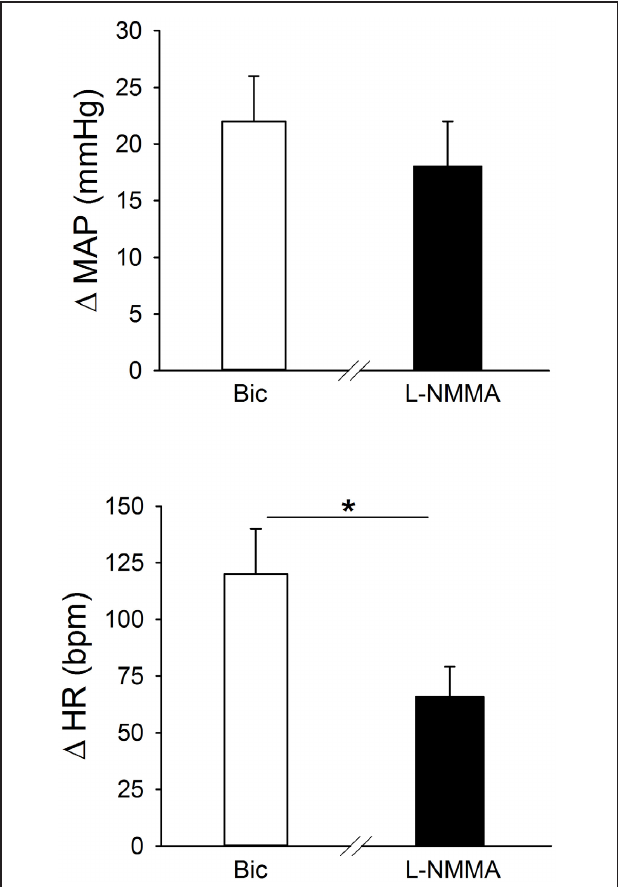
FIGURE 3 | Effects of bilateral blockade in the region of the PVN of GABA A receptors (bicuculline; Bic, 1mM; open bars; n = 7), or NO synthase (NOS) (L-NMMA; 2mM, filled bars; n = 6) on MAP and HR in separate groups of conscious rats. Bilateral microinjection of both Bic and L-NMMA significantly increased MAP and HR. The pressor response to Bic and L-NMMA was similar, while the tachycardic response to L-NMMA was significantly less than the response to Bic ( ∗ p ≤ 0 .